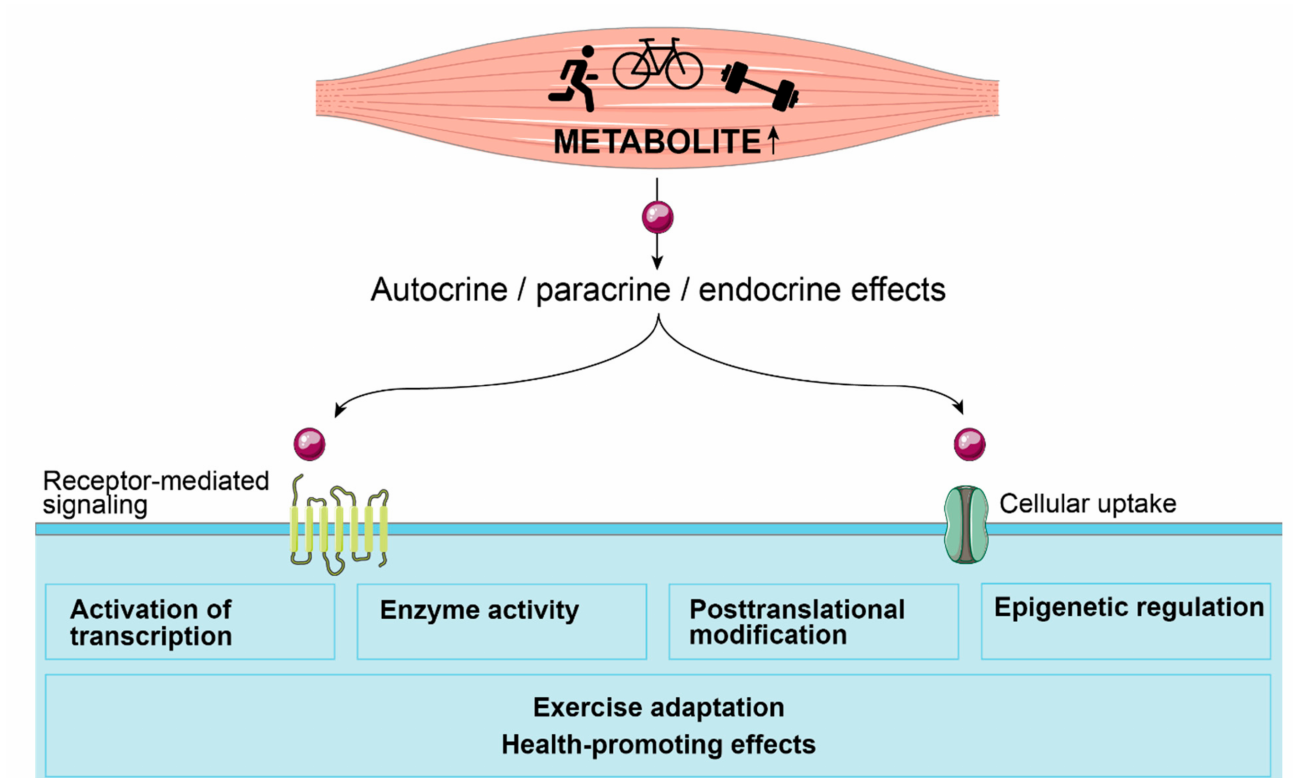
Figure 1. The concept of myometabokines. Metabolites released from the contracting skeletal muscle can regulate transcription and translation, enzyme activities and signaling cascades by binding to receptors or after transporter-mediated cellular uptake. By initiating these events in the skeletal muscle or in other tissues, adaptive responses to physical activity are supported. The figure was created using Servier Medical Art templates, which are licensed under a Creative Commons Attribution 3.0 Unported License; https://smart.servier.com (accessed on 22 June